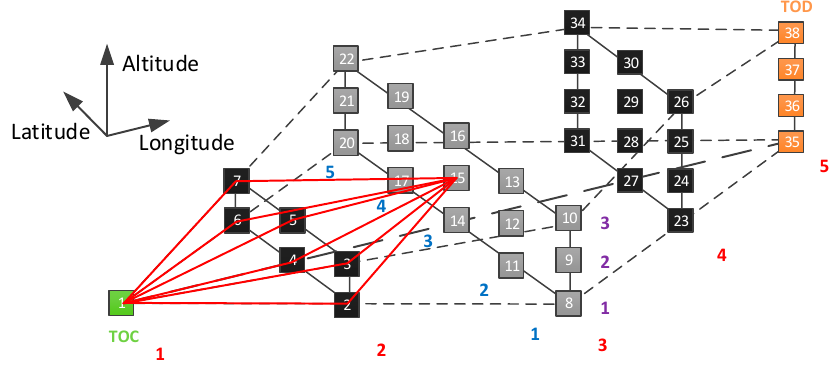
Figure 2. 3D search space for the cruise phase .